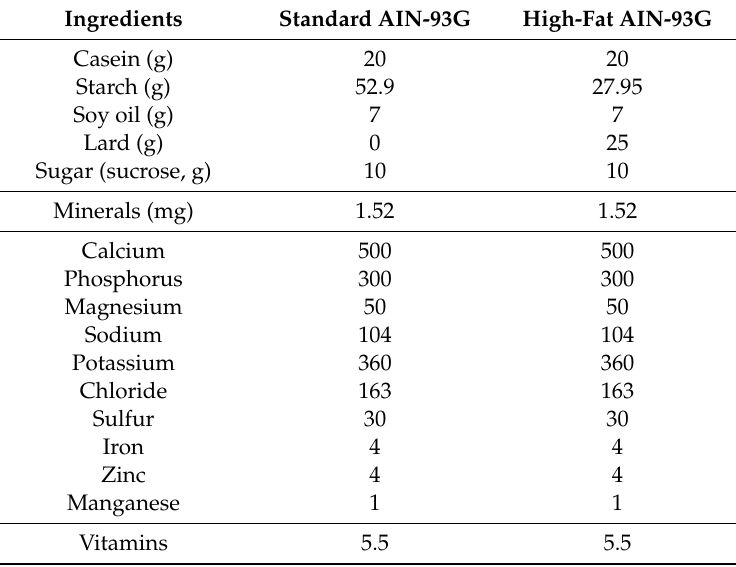
Table 1. Ingredients and nutritional feed composition (100